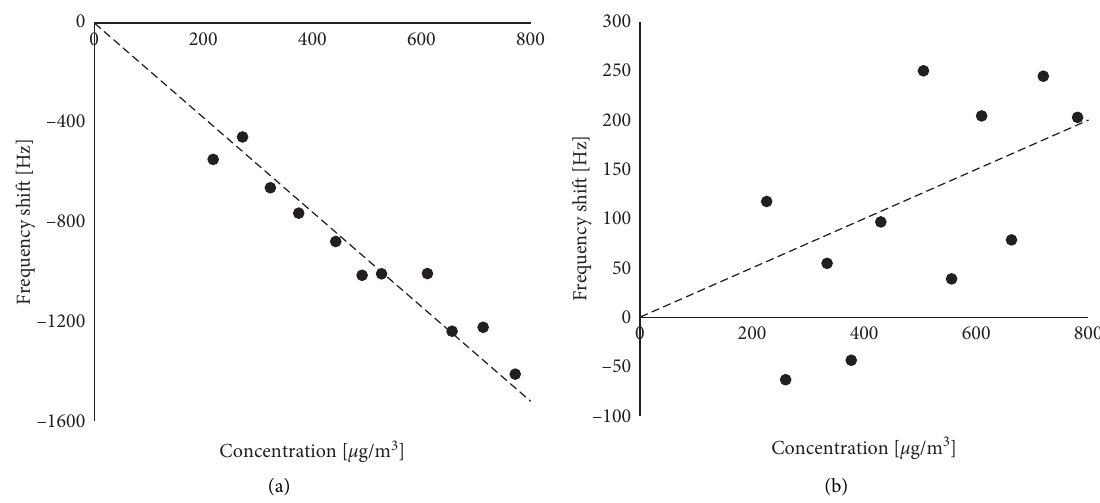
Figure 10: The frequency shift of the 315MHz SAW vs. the concentration of aerosols generated by (a) A1 and (b) A4 Arizona dust, measured in the 35 m 3 testing room.